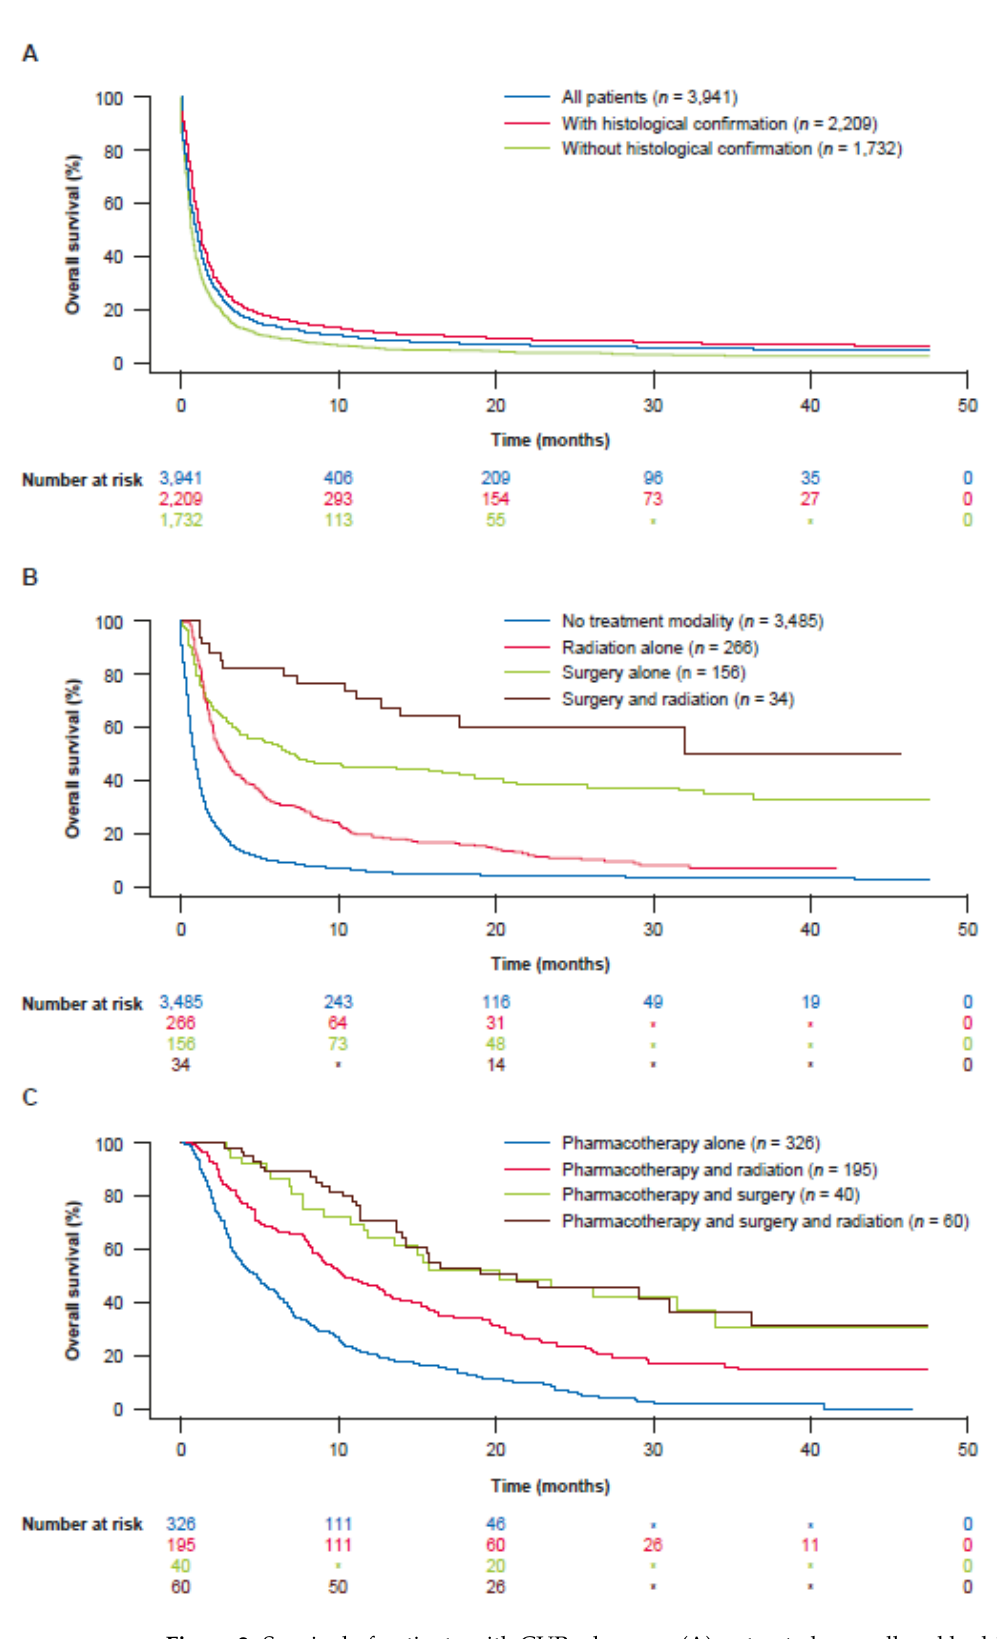
Figure 2. Survival of patients with CUP who were ( A ) untreated, overall and by histologic confir- mation status, ( B ) treated without pharmacotherapy, and ( C ) treated alongside pharmacotherapy. * Suppressed data based on NCI guidelines for confidentiality. CUP, cancer-of-unknown-primary- origin; NCI, National Cancer Institute. See Table S4 for further data on patient survival.